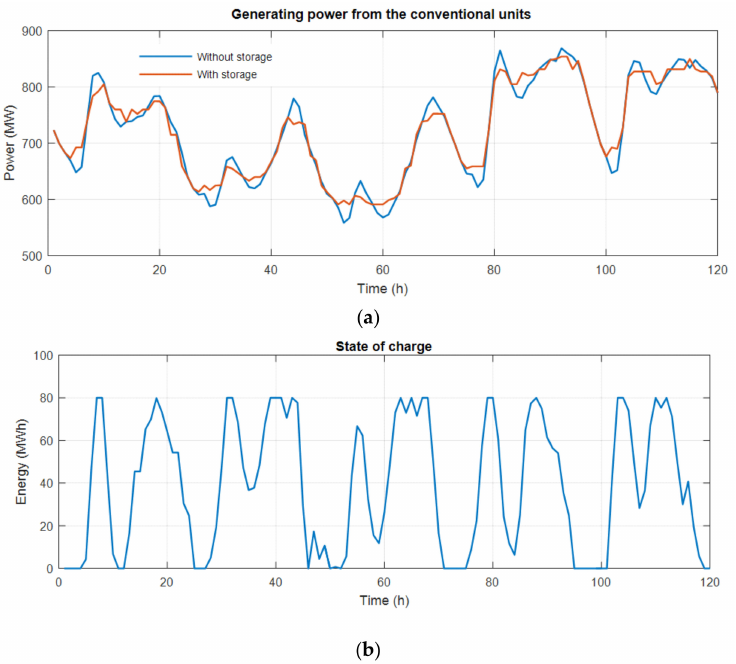
Figure 4. ( a ) Generating power from conventional power plants with and without the use of storage and ( b ) State of charge of the 80 MWh